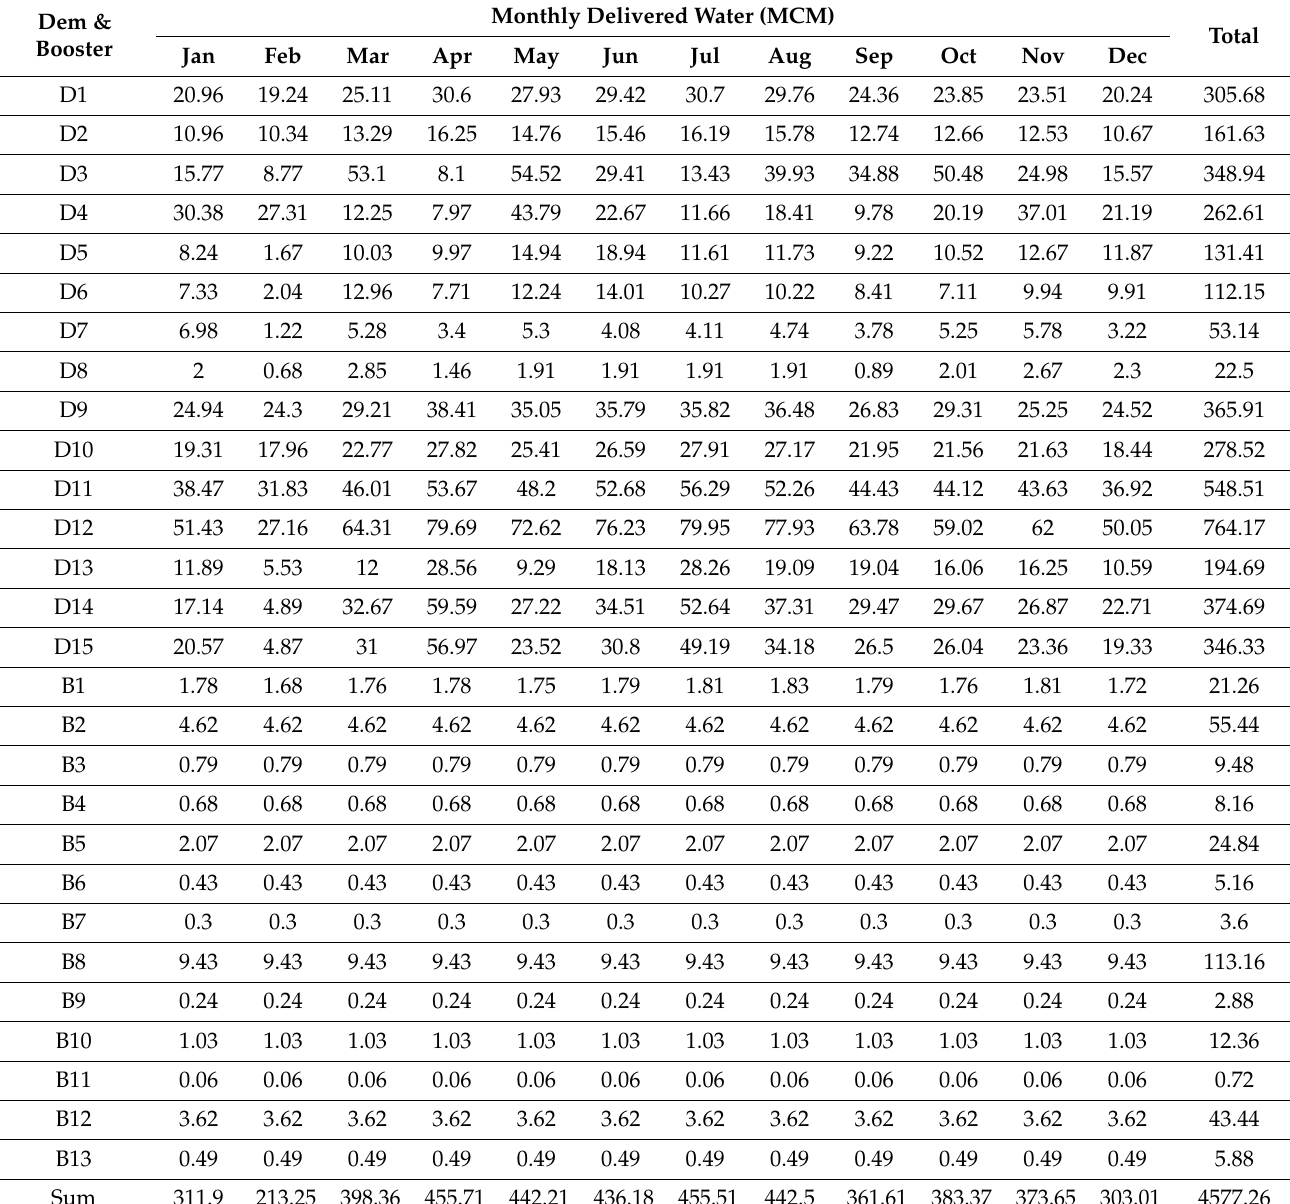
Table 8. Monthly water distribution in the study area